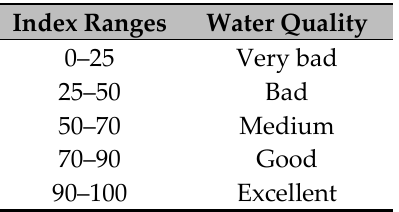
Table1. Water quality Index